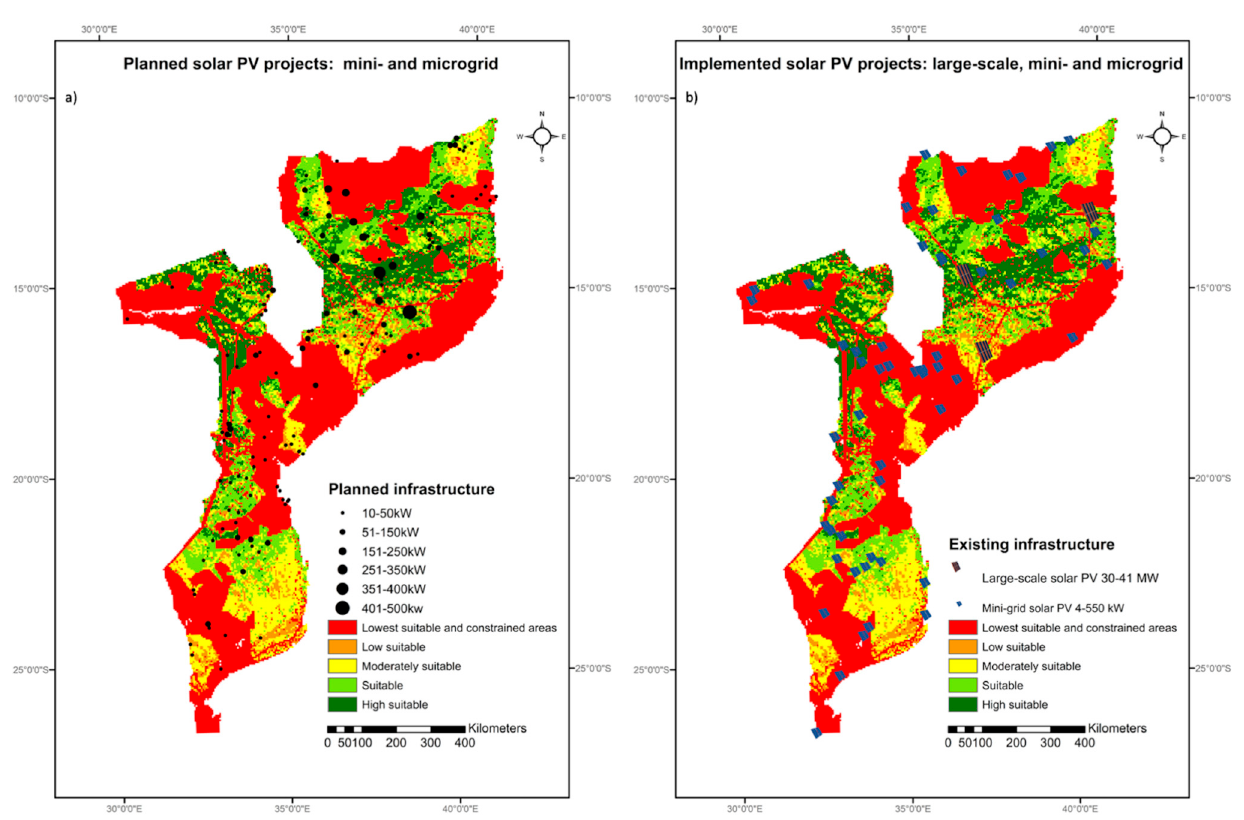
Figure 14. Model performance verification: ( a ) planned minigrid and microgrid solar PV projects and ( b ) implemented large-scale, minigrid and microgrid solar PV and ( b ) implemented large-scale, minigrid and microgrid solar PV projects.